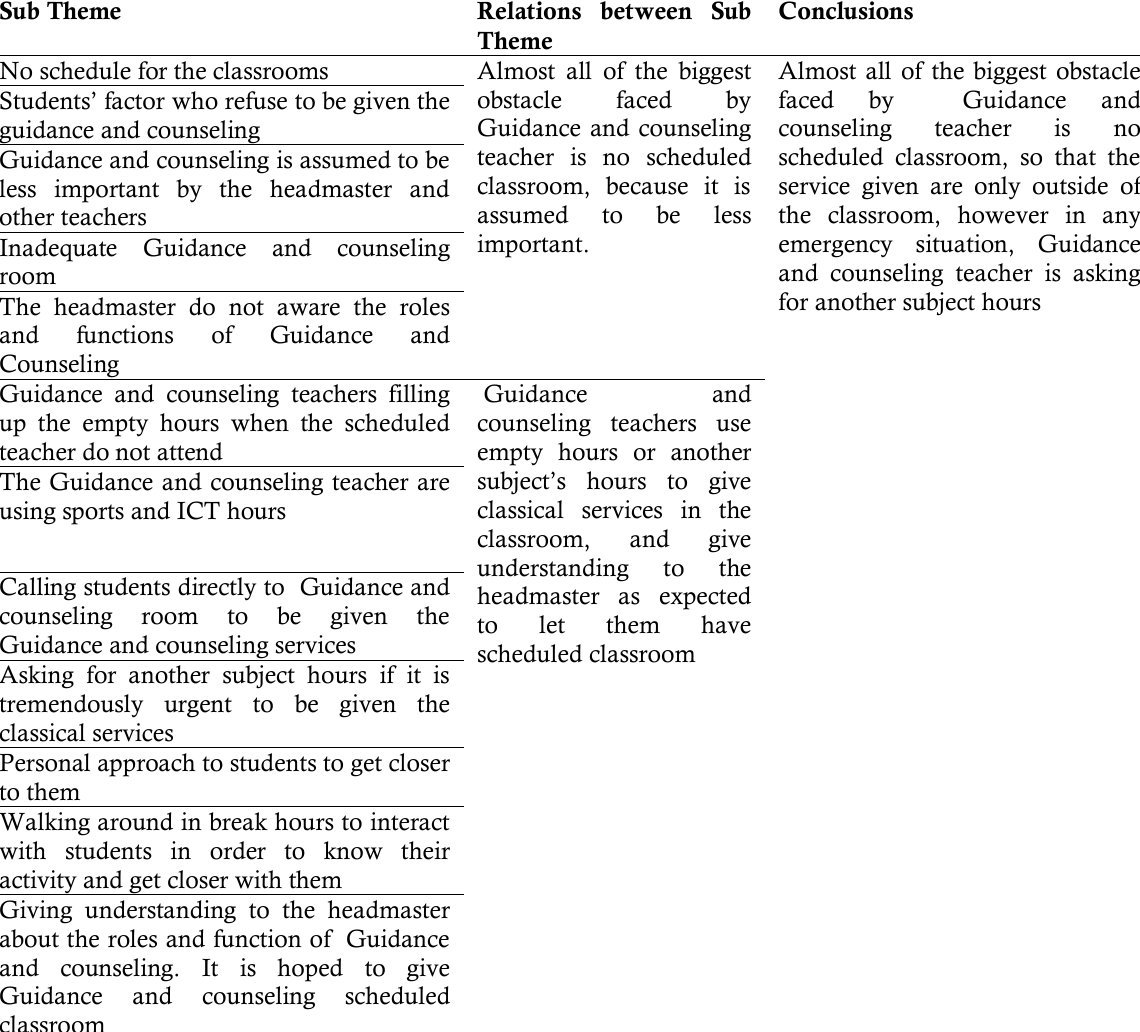
Table 5 . Obstacles and Strategies of Guidance and Counseling Teacher Sub